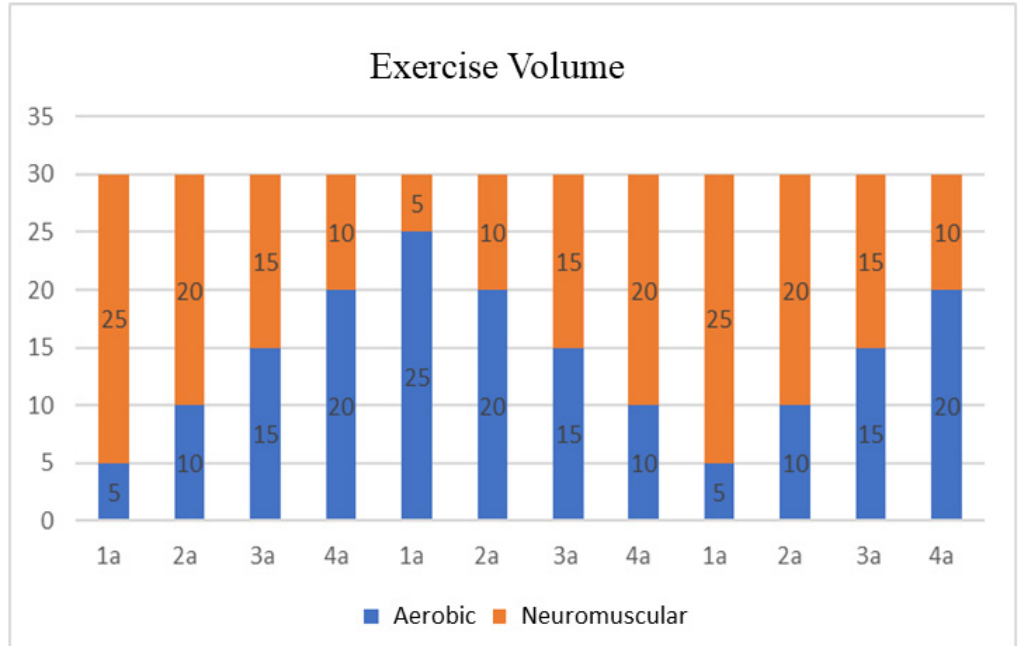
Figure 1 – Exercise Volume distributed in four-week